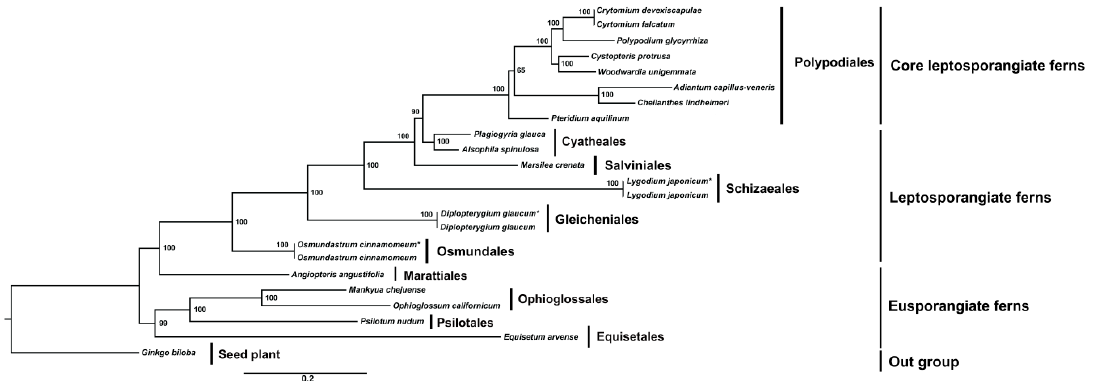
Figure 8. Molecular phylogenetic tree of 23 distinct fern taxa based on 76 protein ‐ coding genes in the cp genome. The tree was constructed by maximum likelihood (ML) analysis of conserved regions using the Randomized Axelerated Maximum Likelihood (RAxML) program and the general time ‐ reversible invariant ‐ sites nucleotide substitution model. The stability of each tree node was tested by bootstrap analysis using 1000 replicates. Bootstrap values are indicated on each of the branches, whereas the branch length reflects the estimated number of substitutions per 1000 sites. The genus Ginkgo was set as the outgroup. * Fossil data cp genomes were used to identify phylogenetic relationships with corresponding taxa.